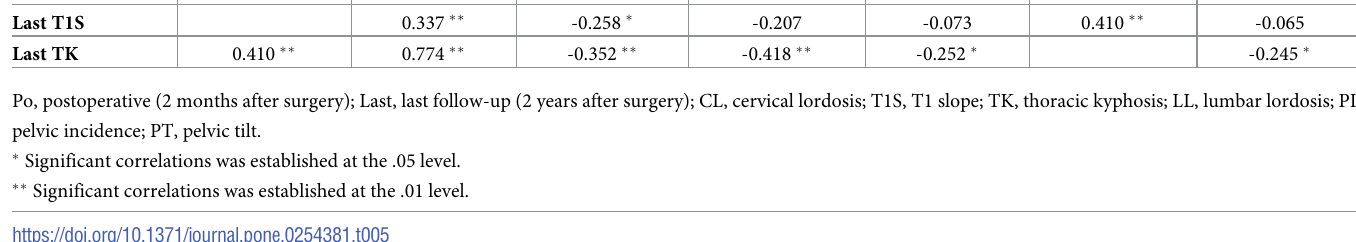
Table 5. Correlations between last follow-up cervical lordosis, T1 slope, thoracic kyphosis and other radiographic parameters. Last T1S Po TK Po LL Po PI-LL Po PT Last TK Last PT